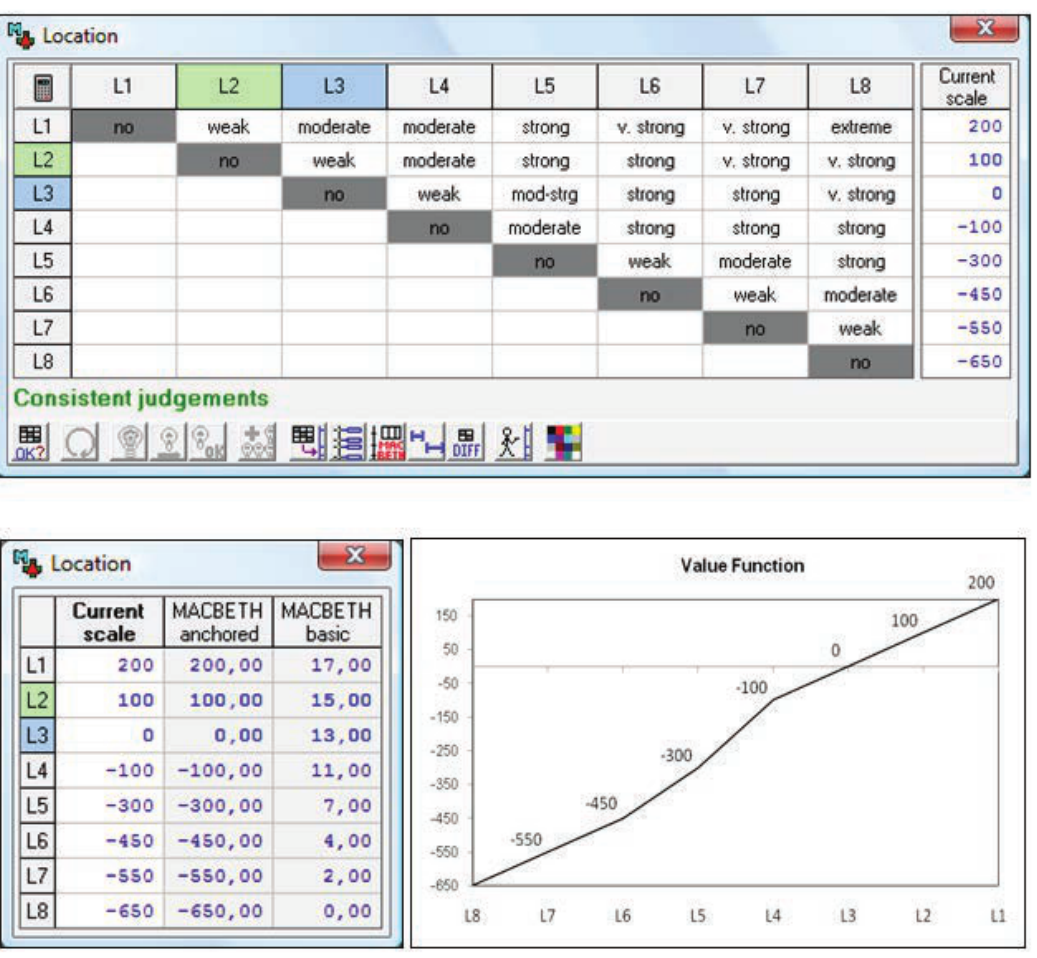
Figure 3. Value judgements, proposed scales and value function of the crt